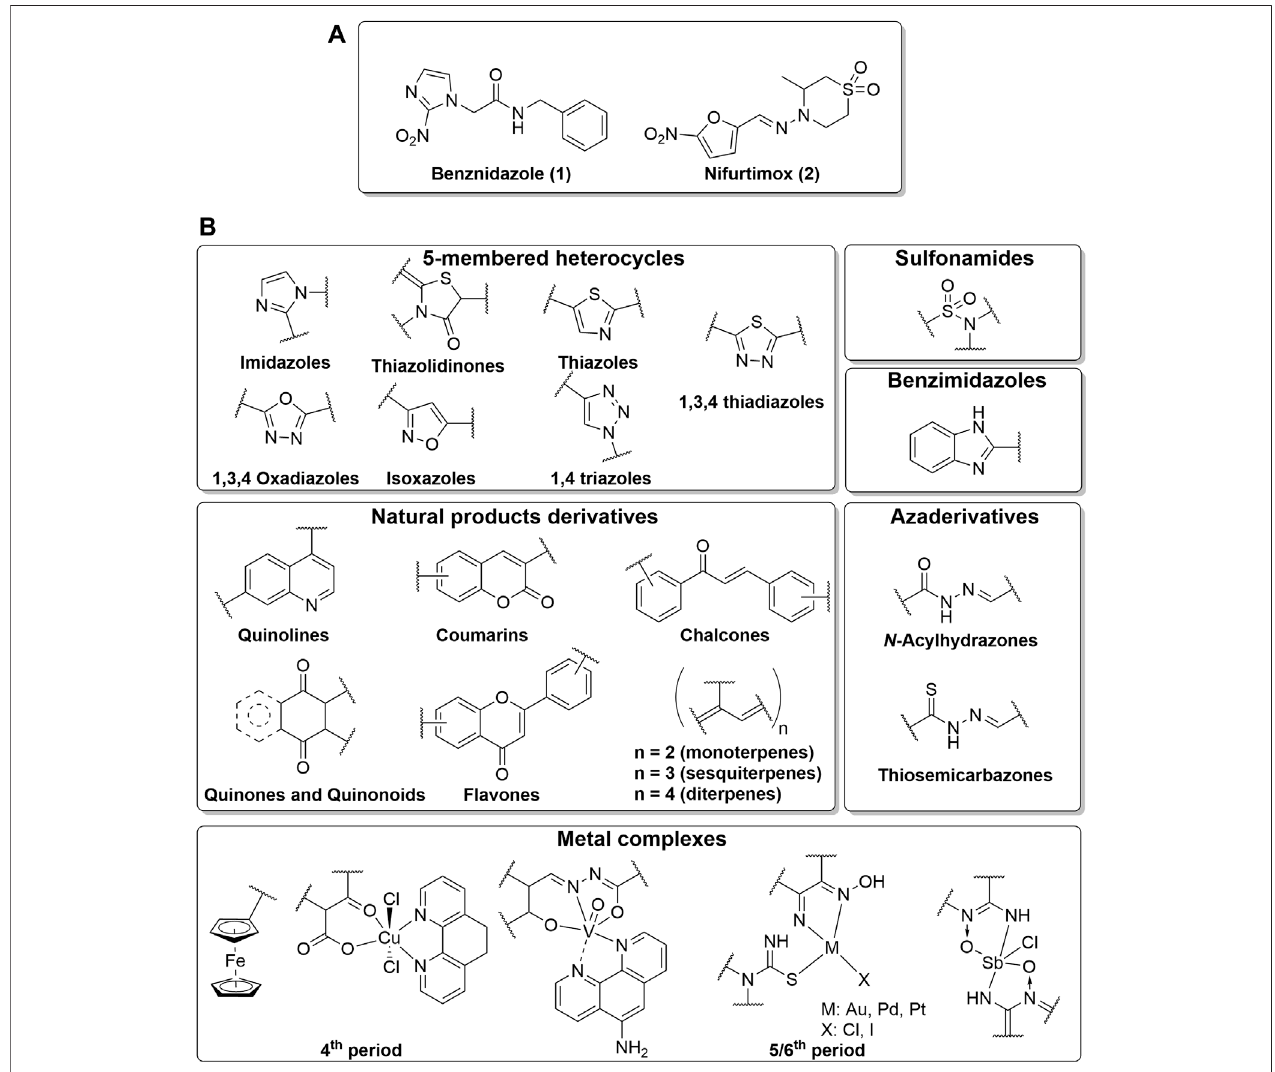
FIGURE 1 | Representative chemical scaffolds. (A) Current drugs used for treatment of Chagas disease, benznidazole (1) and nifurtimox (2). (B) Most common chemical scaffolds reported in the evaluated publications.